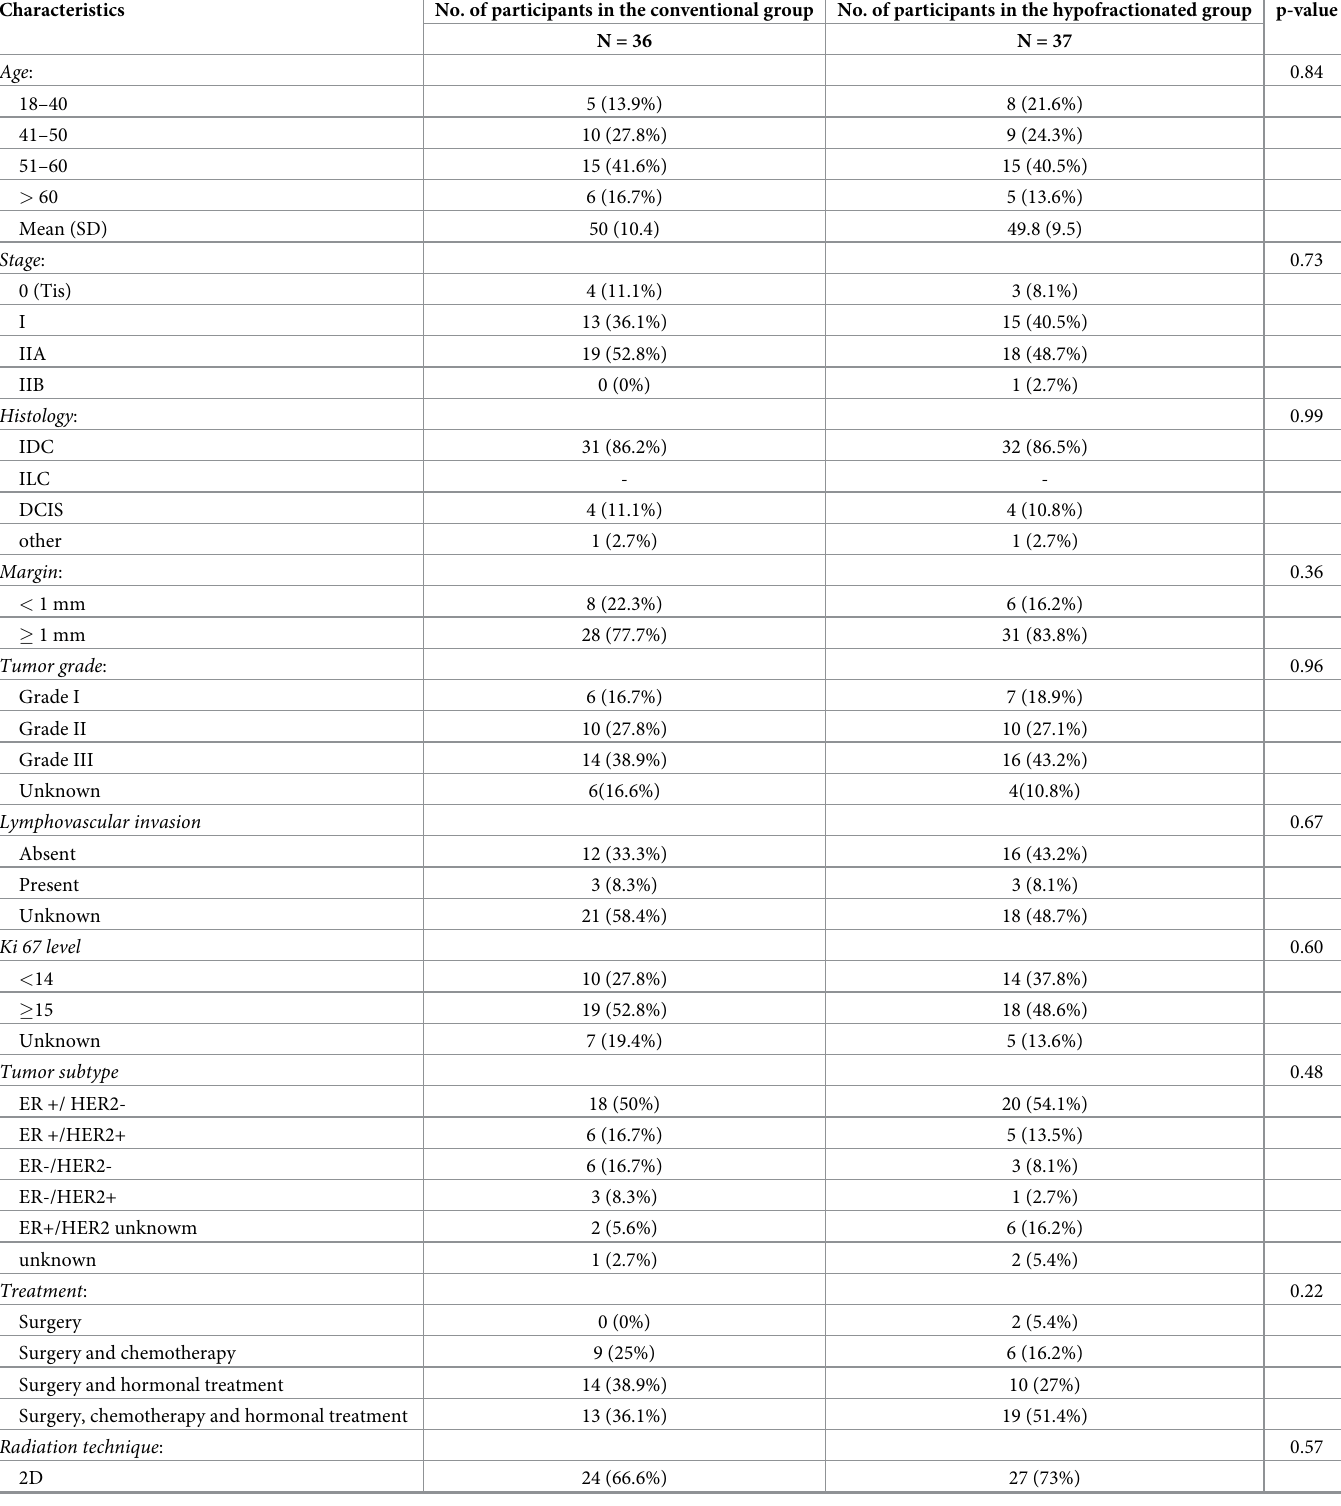
Table 1. Baseline characteristics by fractionation